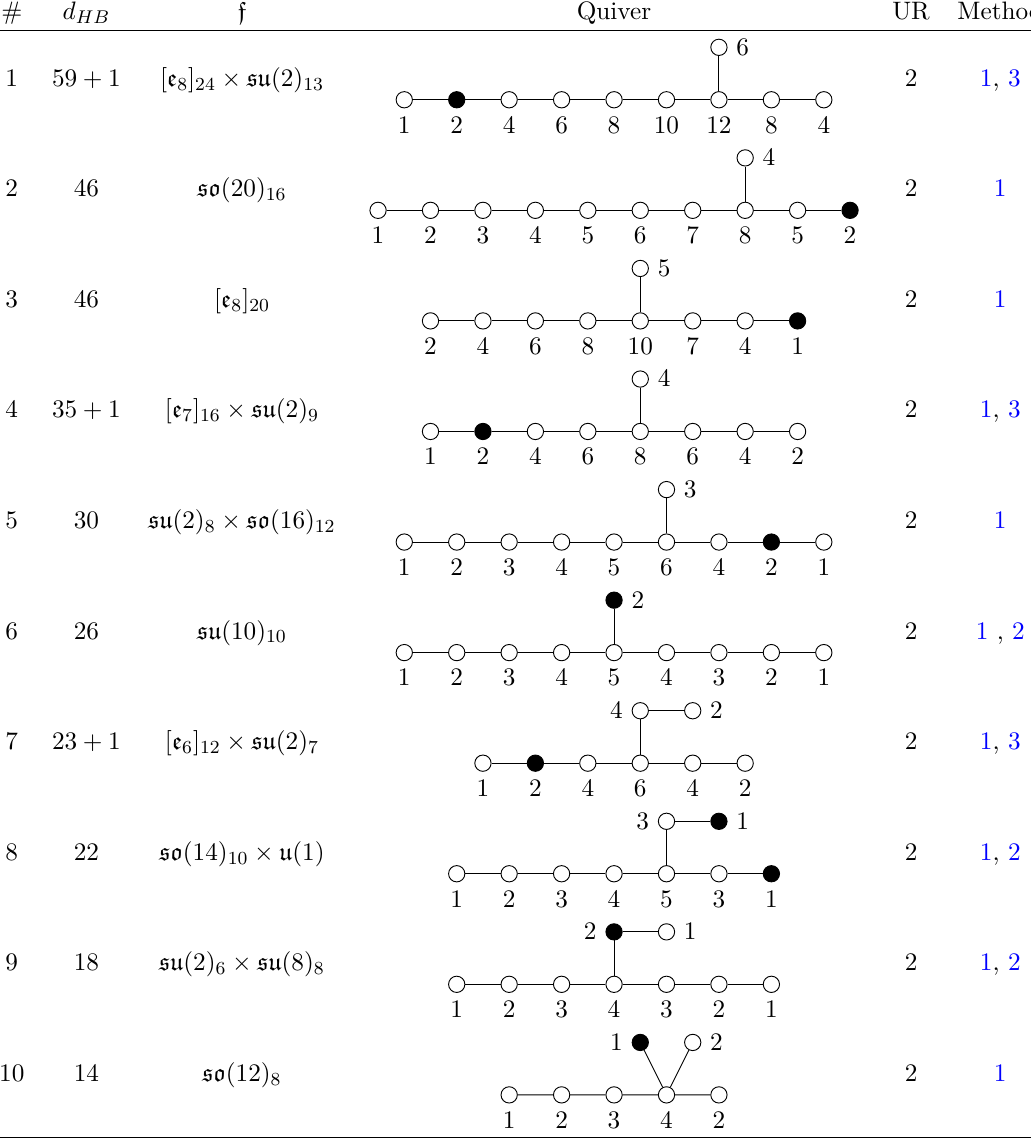
Table 1 . List of magnetic quivers (white nodes are balanced, black nodes are overbalanced). d HB is the quaternionic dimension of the Higgs branch, and f is the flavor symmetry algebra. UR denotes the Unfolded Rank, by which we mean the quaternionic dimension of the Higgs branch of the unfolded magnetic quiver. The last column points to the method used to derive the